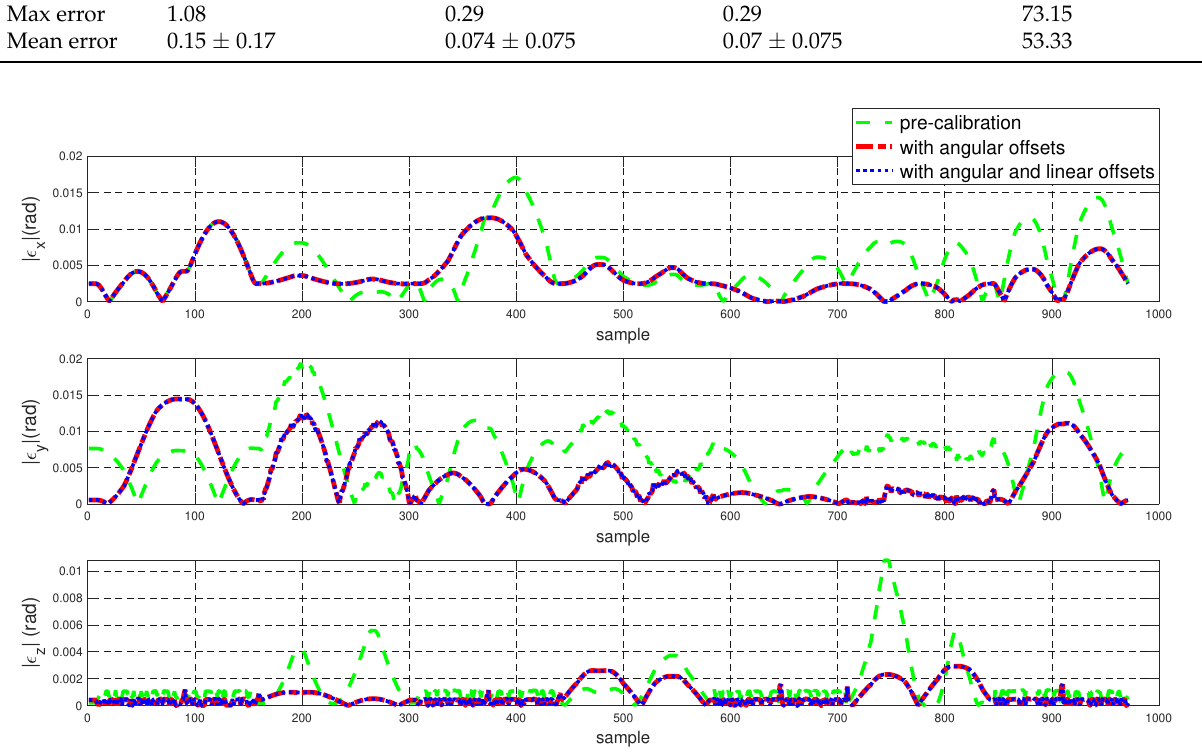
Figure 4. Error in end-effector orientation ( R T (cid:101) R − I ) ∨ for the training dataset before and after calibration (where R and (cid:101) R are the end-effector rotation matrices obtained using the kinematic model and the feedback